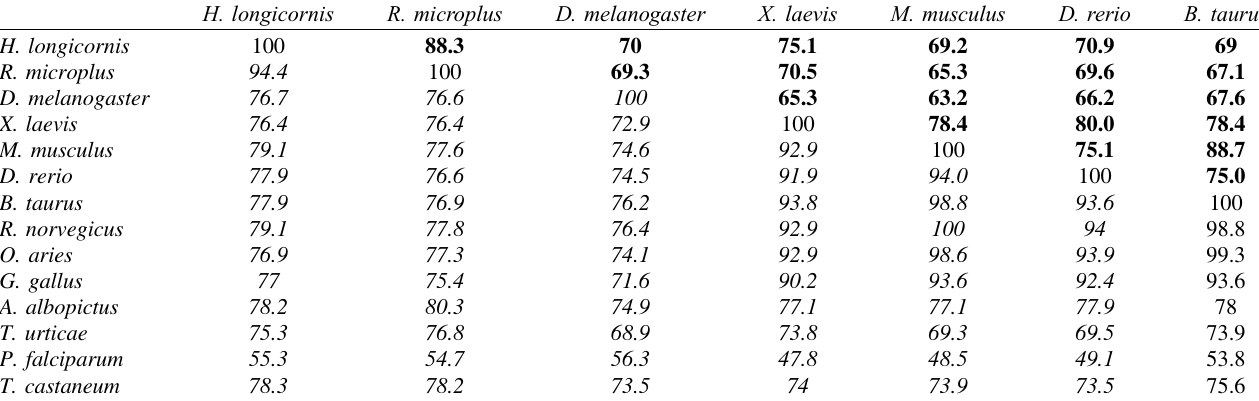
Figure 2. Multiple sequence alignment of deduced GSK-3 b amino acid sequences from different species. Asterisks indicate conserved residues. Conserved GSK-3 b active sites are indicated in boxed letters (N-terminal conserved glycine, amino acids 59 and 282), as are conserved phosphorylation sites of serine and threonine (amino acid 9 and 216, respectively). Table 2. The percentage identity of amino acid (lower diagonal italics letter) and nucleotide (higher diagonal bold letter) sequences of GSK-3 b H. longicornis and different